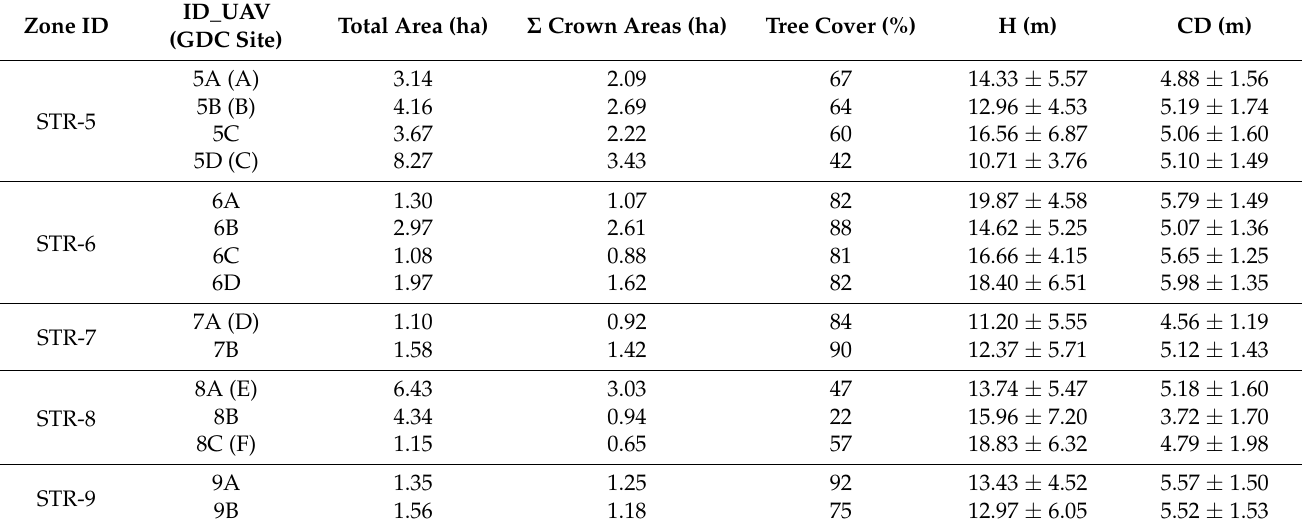
Table 3. UAV remotely sensed dataset acquired for the five monitored